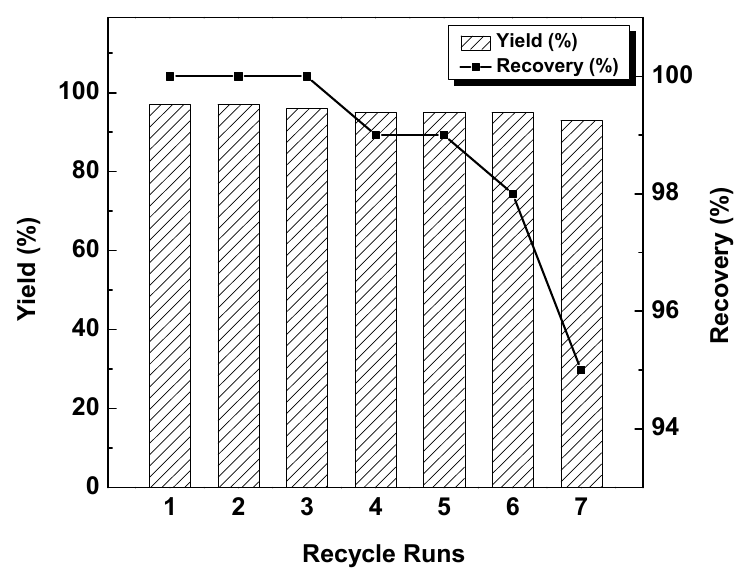
Figure 4. ( a ) Image of Au-SiO 2 @Fe 3 O 4 -RGO suspension before the reaction. ( b ) Image of the reaction system with an additional magnet on the side after the reaction.